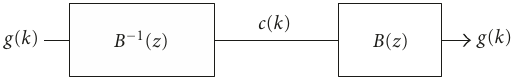
Figure 2: Block diagram of the direct and inverse B-spline filters. g ( k ) are the curve points. B − 1 ( z ) is the direct B-spline filter that computes the B-spline coe ffi cients c ( k ) from g ( k ). B ( z ) is the inverse filter of B − 1 ( z ) and is called indirect B-spline